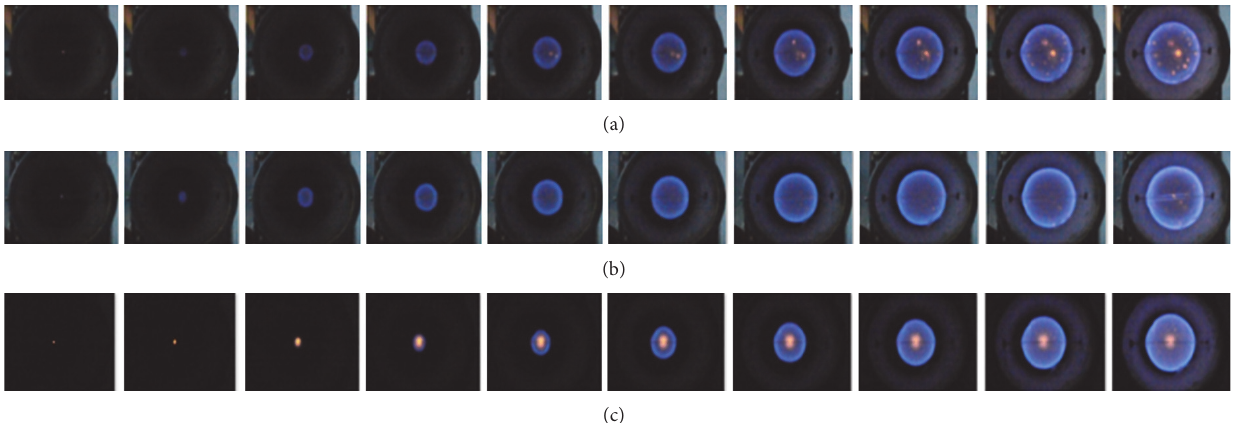
Figure 2: Typical growing image of flame radius with time interval of 2.381 ms ( 𝜙 = 1.1 , 𝑇 = 305 K, and 𝑃 = 1 atm) for (a) hydrous ethanol (95.5% v); (b) anhydrous ethanol (99.7% v); (c) n-heptane.